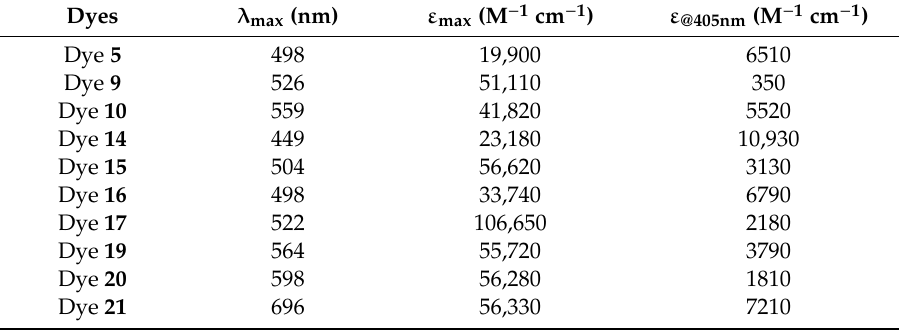
Table 2. Light absorption properties of the selected dyes in acetonitrile: maximum absorption wavelengths λ max ; molar extinction coe ffi cients at λ max ( ε max ) and molar extinction coe ffi cients at the emission wavelength of the LED@405 nm ( ε @405nm